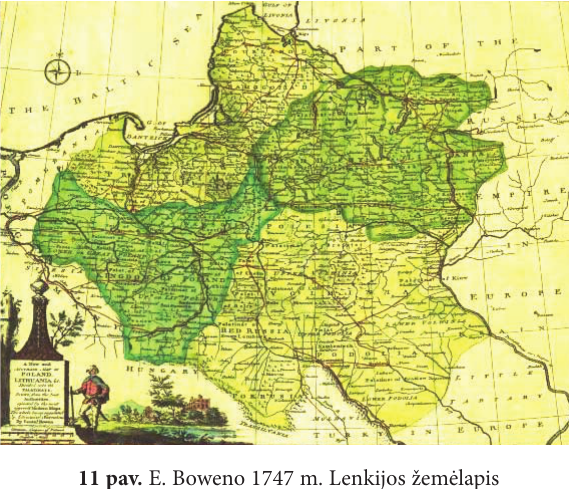
Fig. 11. E. Bowen‘s map of Poland, 1747 (from K. Varnelis